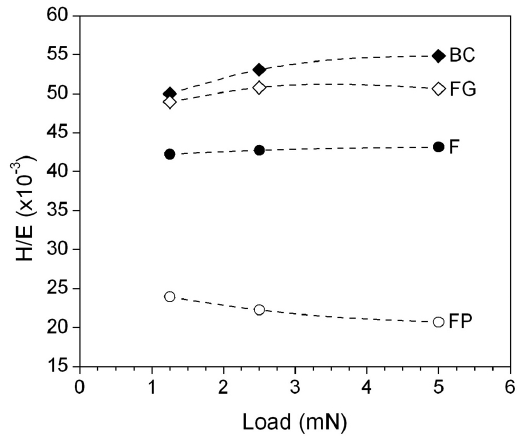
Figure 6. H/E ratios calculated from the nanoindentation tests on the Z250 samples filled with the following sealants: Fortify Plus ® (FP), Fortify ® (F), FillGlaze ® (FG) and BisCover ® (BC). Dashed lines are guides to the eyes.